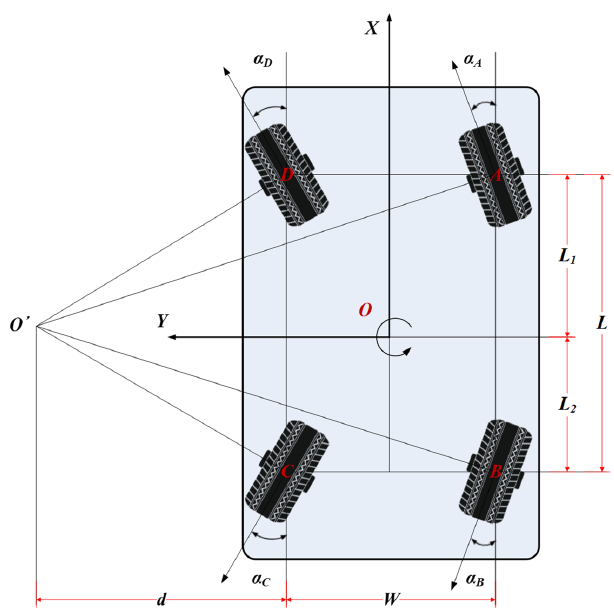
Figure 2. Vehicle four ‐ wheel steering kinematic model.